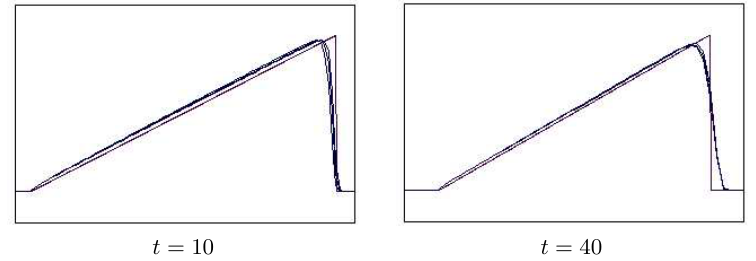
Figure 17. Numerical solution for the Babenko scheme for 6 initial data ( (cid:13) = 0 : 1; 0 : 5; 0 : 9